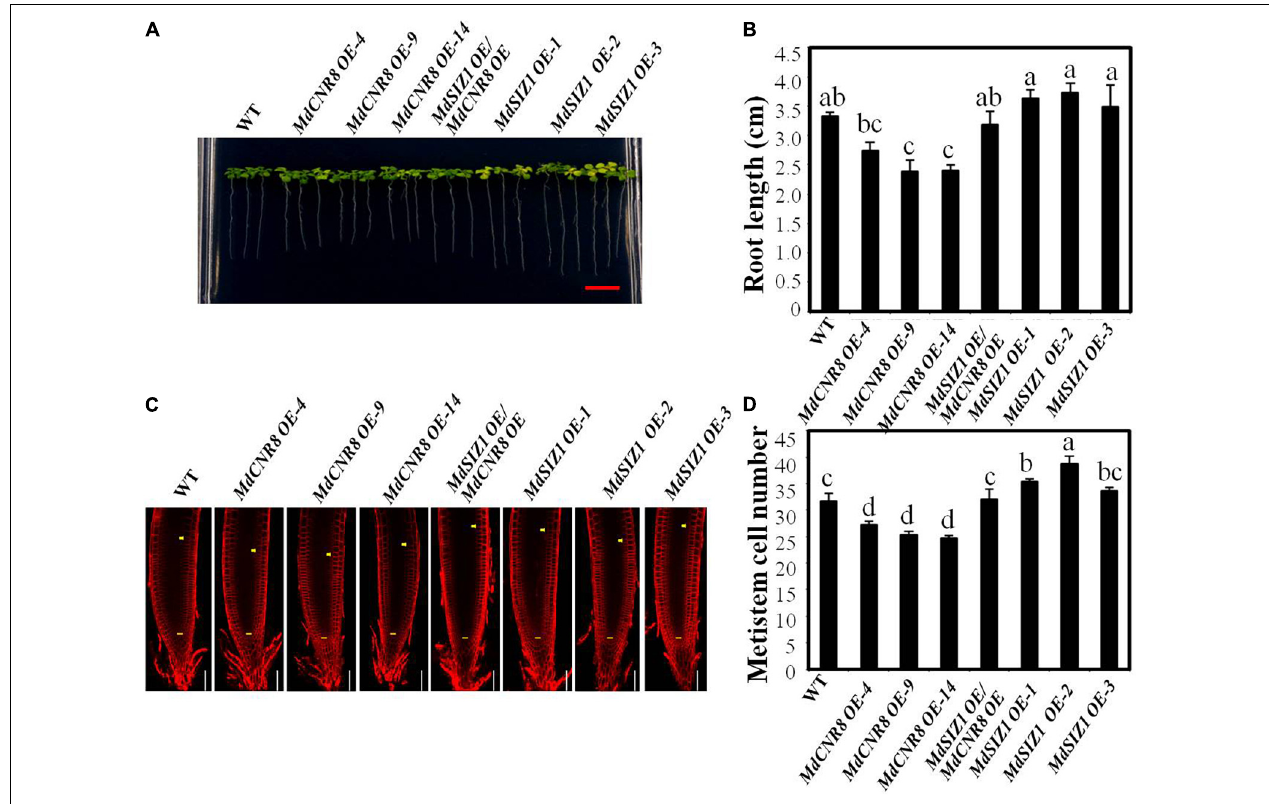
FIGURE 7 | MdSIZ1-mediated SUMOylation of MdCNR8 regulates cell proliferation and root growth in Arabidopsis. (A) Root phenotype of 7-day-old Arabidopsis seedlings of the WT, MdCNR8 overexpression lines (MdCNR8 OE-4, MdCNR8 OE-9, MdCNR8 OE-14), MdSIZ1 overexpression lines (MdSIZ1 OE-1, MdSIZ1 OE-2, MdSIZ1 OE-3), and MdCNR8-OE/MdSIZ1-OE double overexpression line. Bars = 1 cm. (B) Primary root length of 7-day-old Arabidopsis seedlings of the WT, MdSIZ1 OE-1, MdSIZ1 OE-2, MdSIZ1 OE-3, MdCNR8 OE-4, MdCNR8 OE-9, MdCNR8 OE-14, and MdCNR8-OE/MdSIZ1-OE double overexpression line. Data are the means ( n = 20) ± SD. Different letters on each bar denote significant differences ( p < 0.05, ANOVA, Tukey’s correction). (C) Confocal microscopy images of the FM4-64-stained WT, MdCNR8 overexpression lines (MdCNR8 OE-4, MdCNR8 OE-9, MdCNR8 OE-14), MdSIZ1 overexpression lines (MdSIZ1 OE-1, MdSIZ1 OE-2, MdSIZ1 OE-3), and MdCNR8-OE/MdSIZ1-OE double overexpression Arabidopsis seedlings. Yellow arrows and horizontal lines indicate the approximate position of root meristem zone. Bars = 50 µ m. (D) Meristem cell number of the WT, MdSIZ1 OE-1, MdSIZ1 OE-2, MdSIZ1 OE-3, MdCNR8 OE-4, MdCNR8 OE-9,